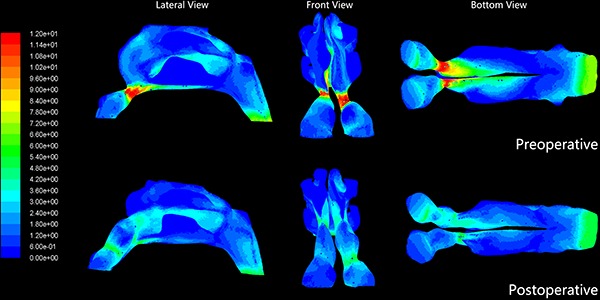
Pre- and postoperative airflow velocity distributions of the nasal cavity in one patient with anterior nasal cavity stenosis. Comparison of pre- and postoperative velocity distribution revealed that the largest velocity appeared in the nasal valve area. Red color indicates higher velocity.